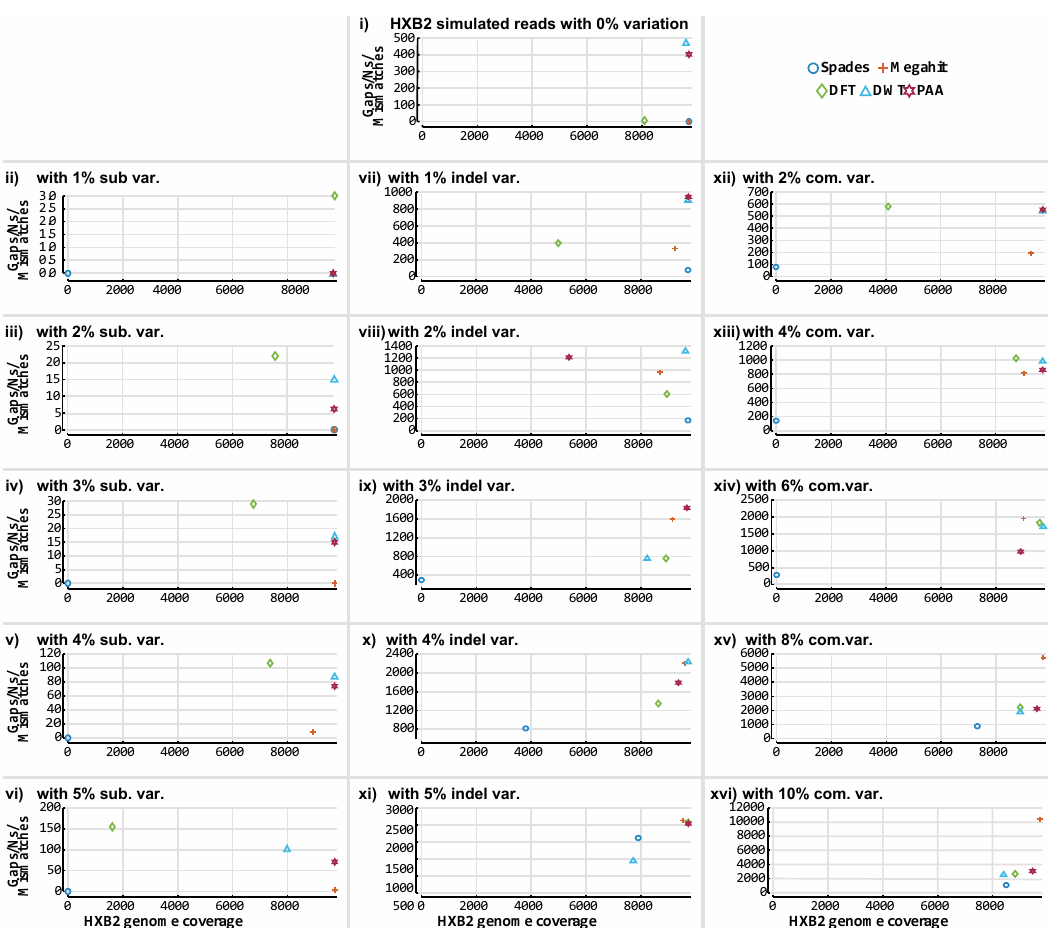
Figure 11. Accuracy of our prototype de novo assembly implementation and two established tools on HIV-1 HXB2 simulated datasets. The contigs obtained for each assembler were evaluated against the reference genome used to generate the simulated data. BLASTn was used to align all contigs to an HIV-1 HXB2 reference genome and determine genome coverage. The y -axis indicates the number of gaps and mismatches that exist in the contigs obtained for each tool, and the x -axis depicts the length of the genome the reported contigs cover. The contigs obtained from the assembly of the HIV-1 HXB2 simulated short read data were evaluated against the K03455 reference genome. Plot 10- i illustrates results obtained from all assemblers on variation-free data. Plots 10- ii to 10- vi illustrate results obtained from all assemblers on data with different levels of substitution variation. Plots 10- vii to 10- xi illustrate results obtained from all assemblers on data with different levels of insertion/deletion variation. Plots 10- xii to 10- xvi illustrate results obtained from all assemblers on data with different levels of combined insertion/deletion and substitution variation.